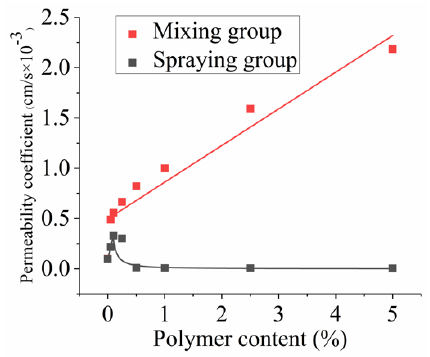
Figure 10. The relationship between the permeability coefficient and polymer content.